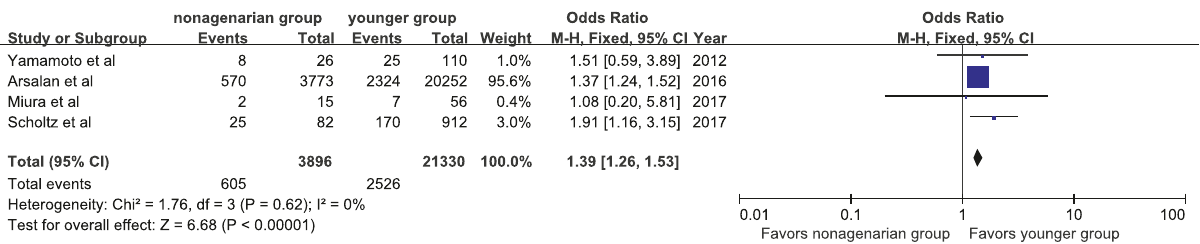
Figure 5: Forest plot of pooled analysis comparing 1-year mortality of nonagenarians versus younger